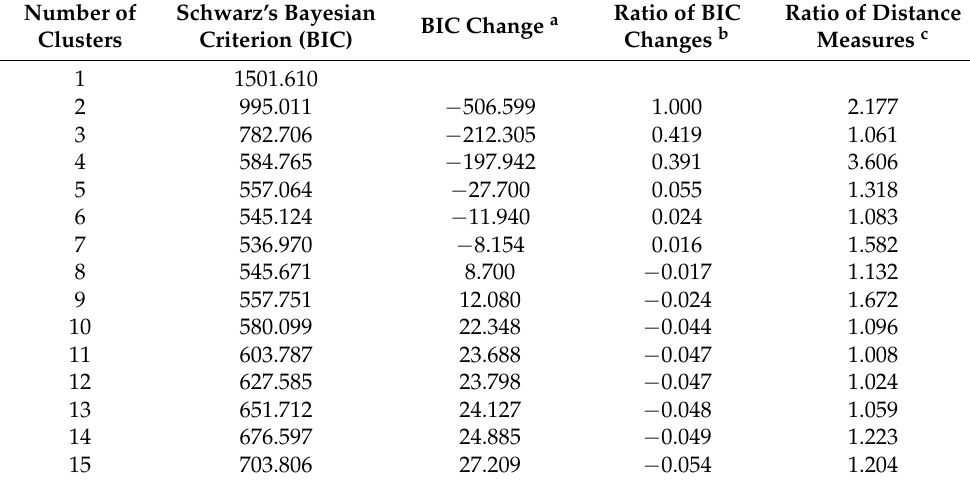
Table 1. Auto-clustering statistics.